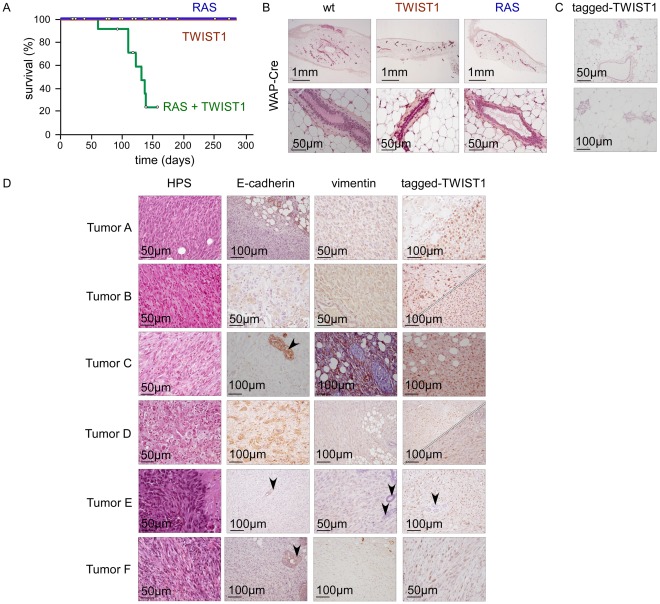
Twist1 promotes tumor initiation in vivo.Transgene expression was driven by WAP-Cre. While WAP-Cre;Twist1 (TWIST1; n = 25) and WAP-Cre;K-RasG12D (RAS; n = 19) mice remained healthy, WAP-Cre;K-RasG12D;Twist1 females (RAS+TWIST1; n = 21) developed metaplastic mammary carcinomas. (A) Kaplan-Meier survival curves of transgenic mice. Survival corresponds to the end point of the experiment, the tumor burden requiring euthanasia of the animal. Open circles indicate mice censored from the dataset. (B) HPS staining of mammary glands from either wild-type (wt), Twist1 or K-rasG12D transgenic mice. (C) Expression analysis of ectopic TWIST1 in mammary glands of nulliparous WAP-Cre;Twist1 mice as assessed by IHC shows that the WAP promoter is active in a few epithelial cells. (D) Characterization of the WAP-Cre;K-RasG12D;Twist1 mice-derived mammary carcinomas (RAS+TWIST1). RAS and TWIST coexpression leads to the development of metaplastic carcinomas characterized by a predominant E-cadherin−, vimentin+ fusiform contingent (tumors A, C, E, F) or the presence of two epithelial-like (E-cadherin+) and fusiform (vimentin+) cell contingents (tumors B and D). For tumors B and D, both epithelial (upper panel) and fusiform (lower panel) cell contingents express the tagged-TWIST1 transgenic protein, demonstrating that fusiform cells originate from the epithelial ones. Normal epithelial cells are arrowed.